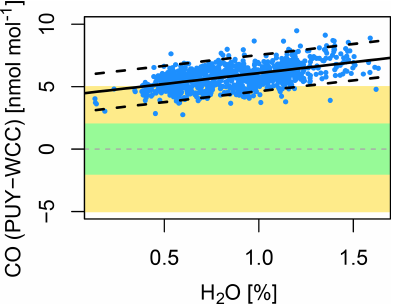
Figure 8. Bias of the PUY Picarro G2401 vs. the water vapour mea- sured by the TI. The solid black line shows the linear regression with a 95% confidence interval (dashed lines). The green and yel- low areas correspond to the WMO network compatibility and ex- tended network compatibility